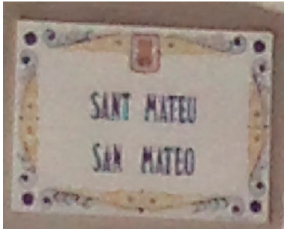
Figure 15. Almazora: Bilingual street name .